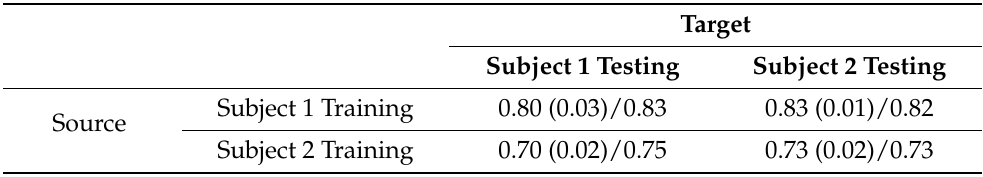
Table 3. A cross-subject experiment was performed on the subjects to evaluate the generalization of the method. The accuracies decreased 0.03 at most when transferring models across